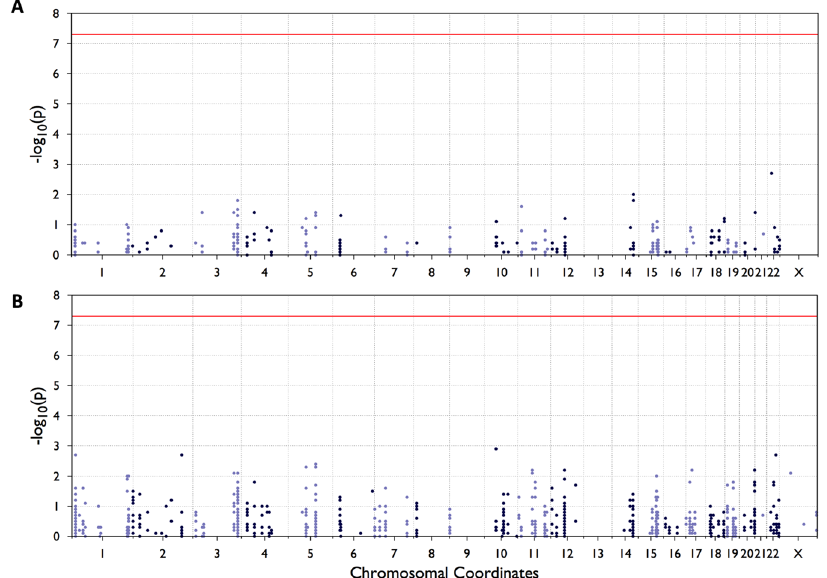
Figure 1. Manhattan plots for common (MAF > 0.05) variants in Norwegian ( A ) and Swedish ( B ) cohorts. Variants located in myelination genes do not reach genome-wide